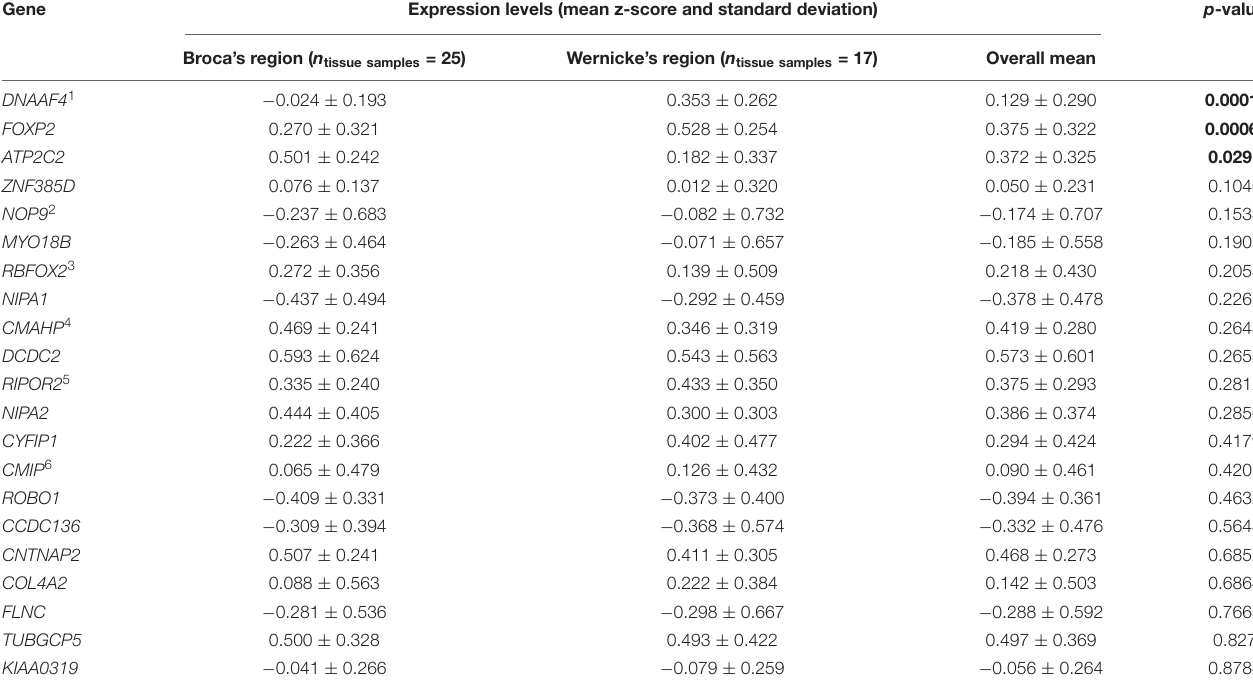
TABLE 2 | Results of the main expression analysis of phonology-related genes.